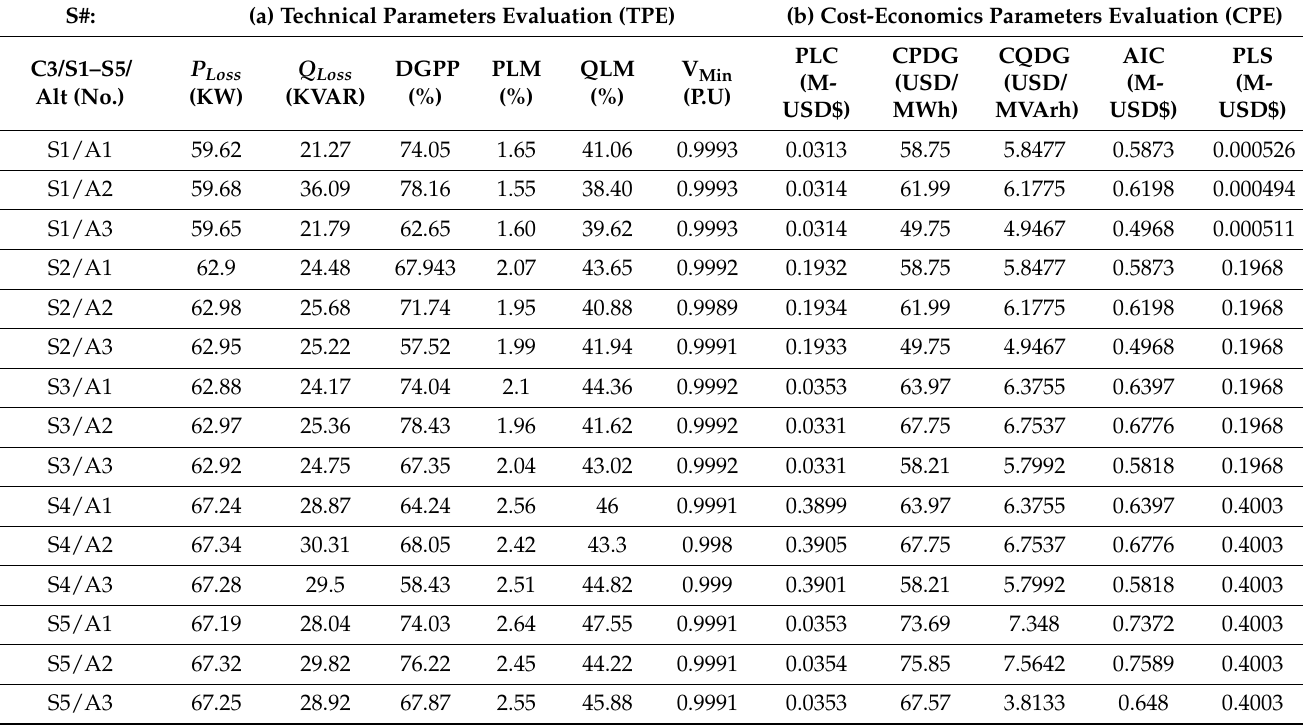
Table 14. TPE/CPE evaluations in C3/S1–S5 for the 65-bus MDN NUST_MG for DG only @ 0.9 LPF.